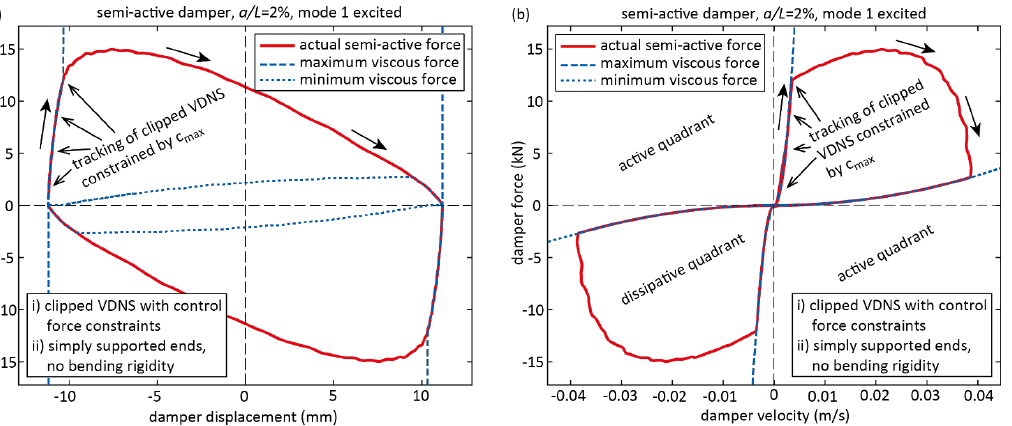
Figure 8. Simulated clipped VDNS with control force constraints for mode 1: ( a ) force displacement curves and ( b ) force velocity curves during steady state conditions (before simulated free decay response).